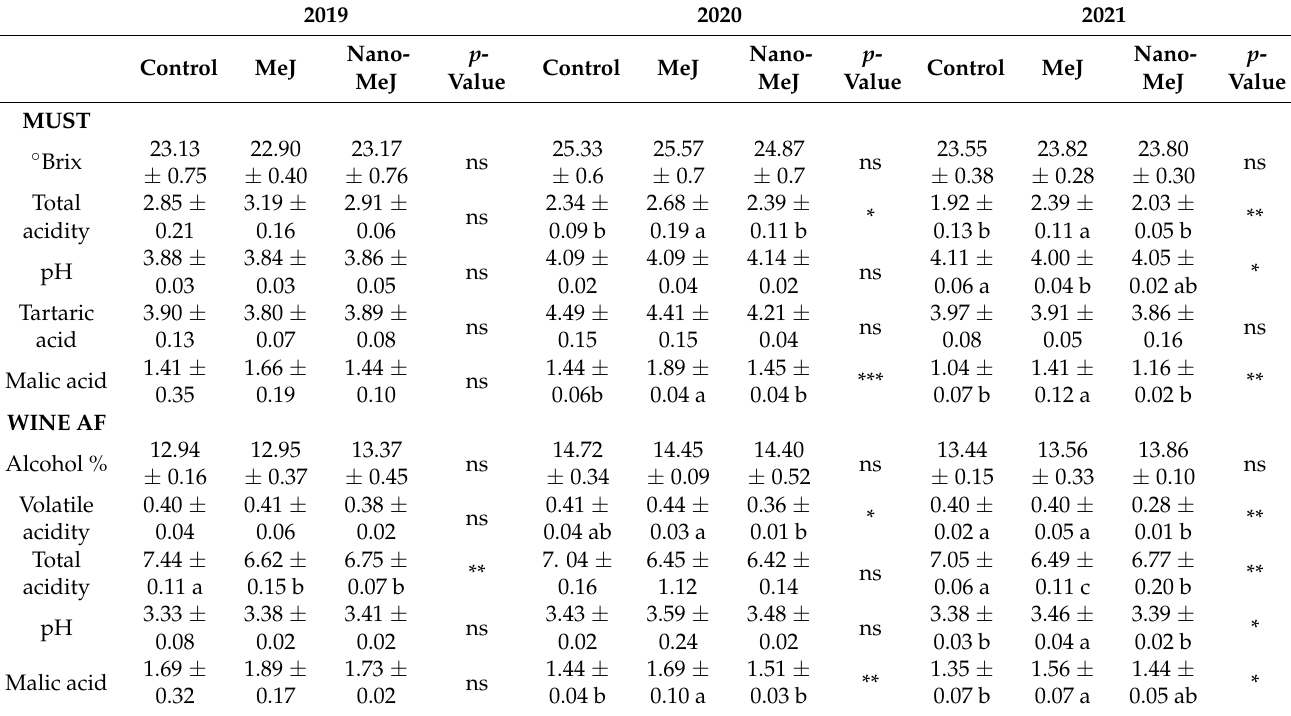
Table 1. Oenological parameters in Monastrell musts and wines elaborated from untreated (control) and treated grapes with foliar applications of Methyl Jasmonate (MeJ) and Nano Methyl Jasmonate (Nano-MeJ) at the end of alcoholic fermentation (AF) in 2019, 2020, and 2021